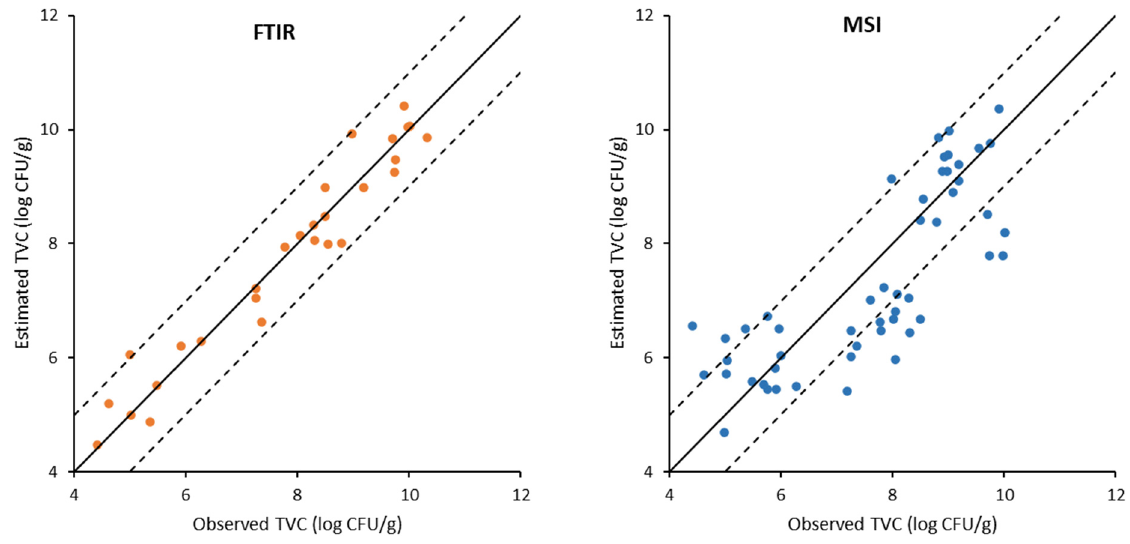
Figure 5. Correlation of observed and estimated values of total viable counts (TVC) on gilthead sea bream fillets during storage under MAP conditions, generated by the PLS-R model based on FT-IR and MSI data. Solid line indicates the line y = x (equity); dashed lines indicate deviation of ± 1 log unit.